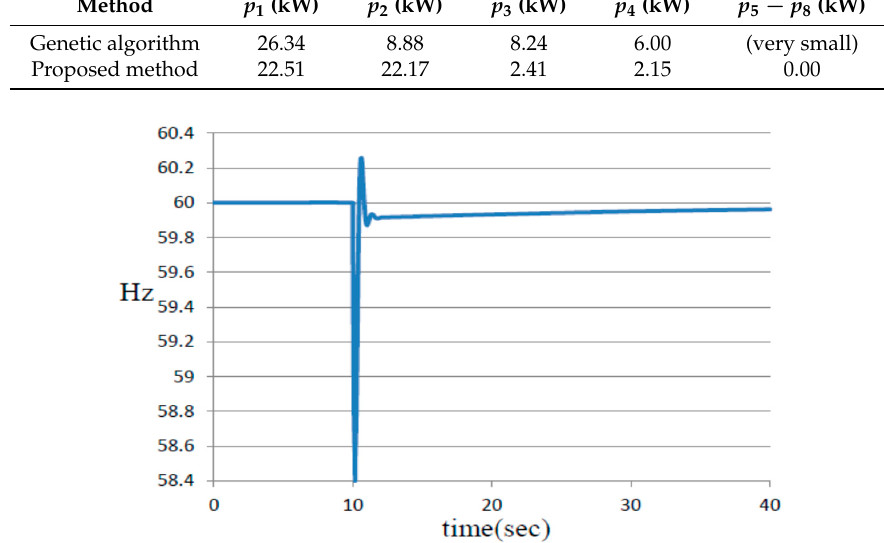
Figure 4. System frequency response obtained using genetic algorithm.